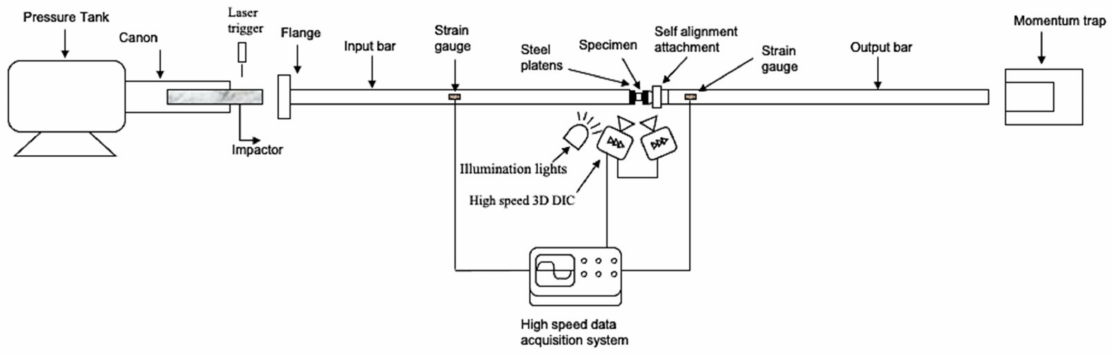
Figure 4. Schematic of the SHPB